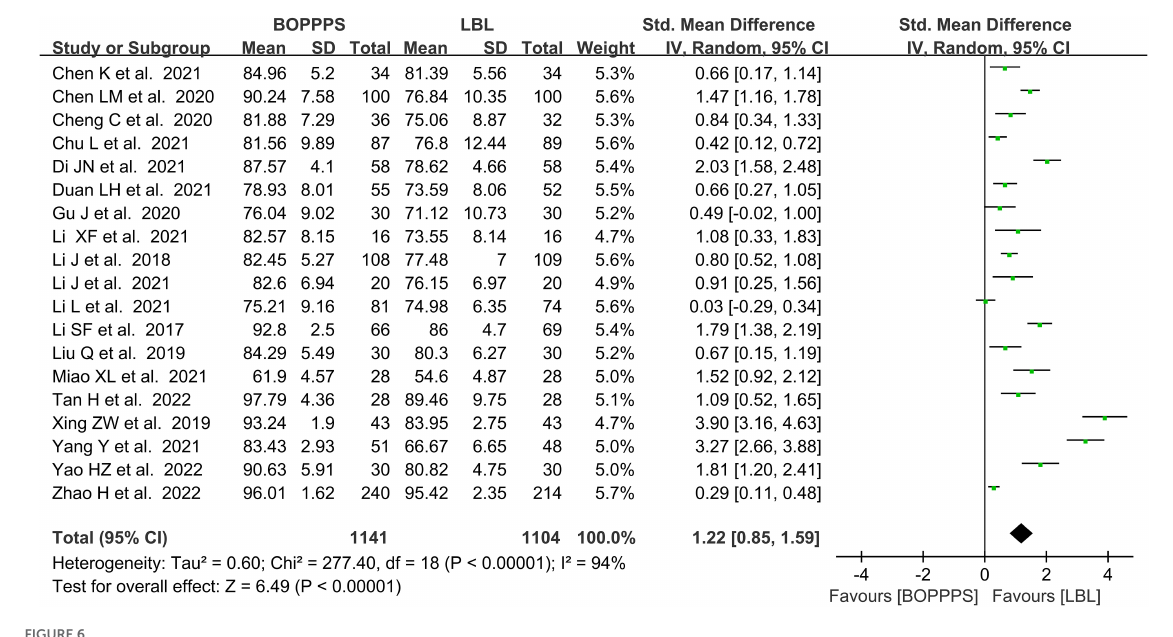
FIGURE6 Forest plot of comprehensive ability scores for BOPPPS compared with